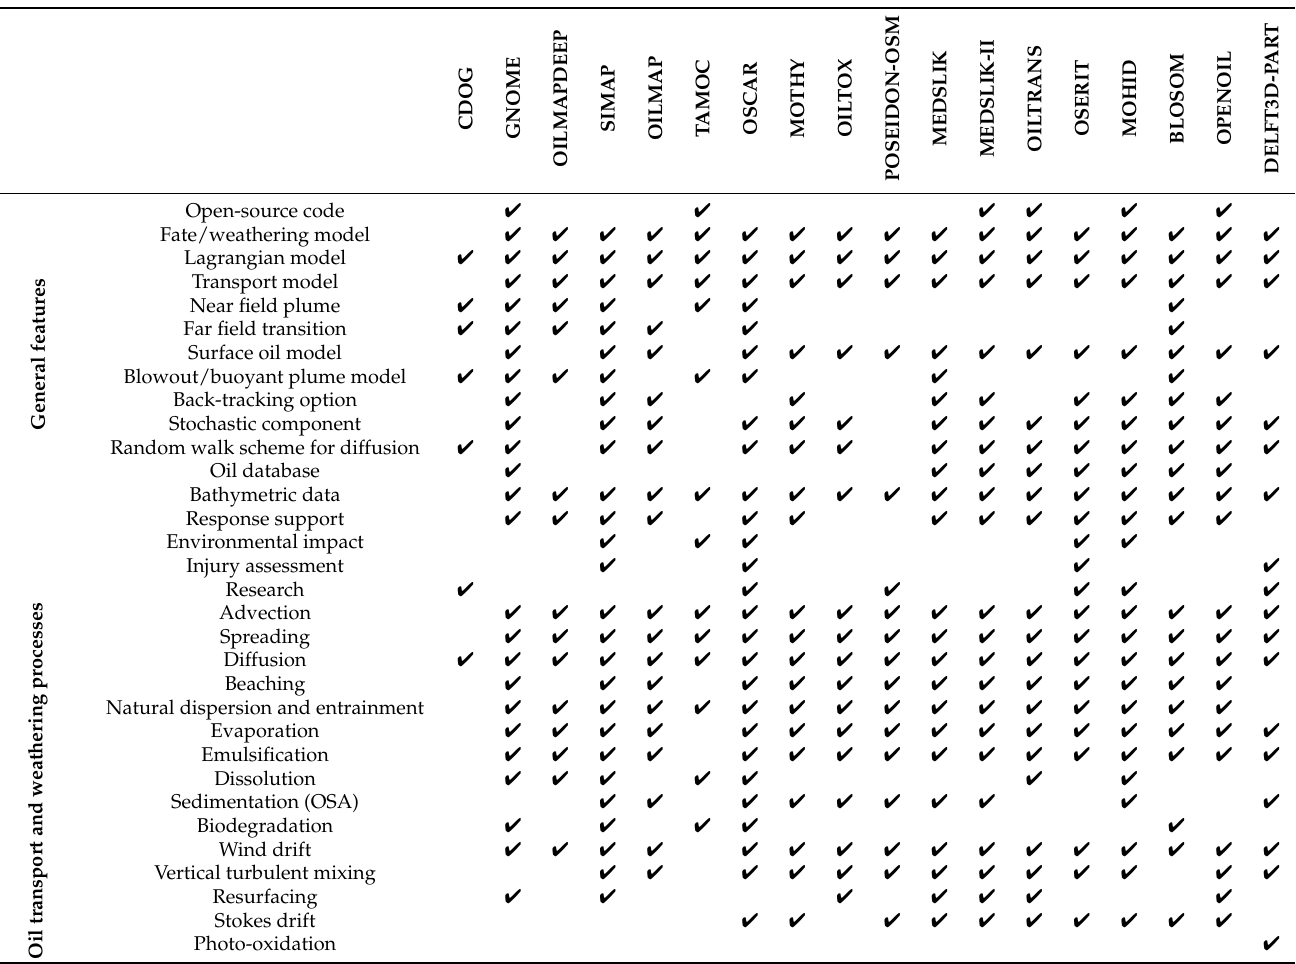
Table 2. Comparison of the oil spill